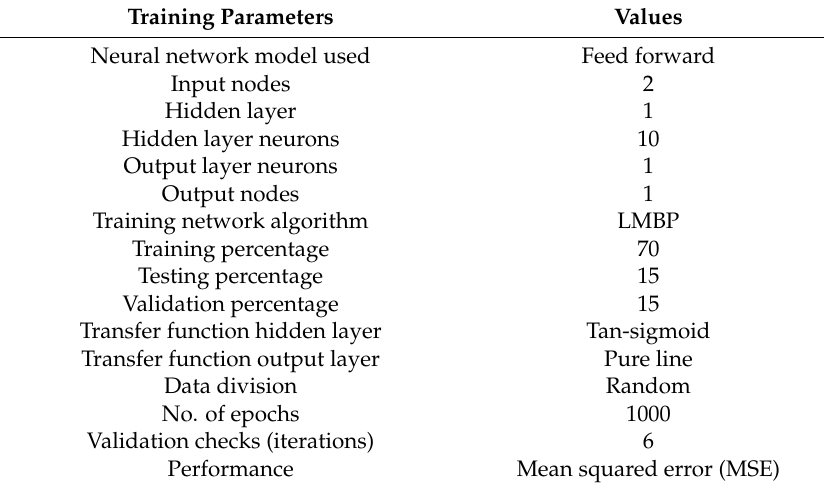
Table 1. The specifications and parameters of ANN